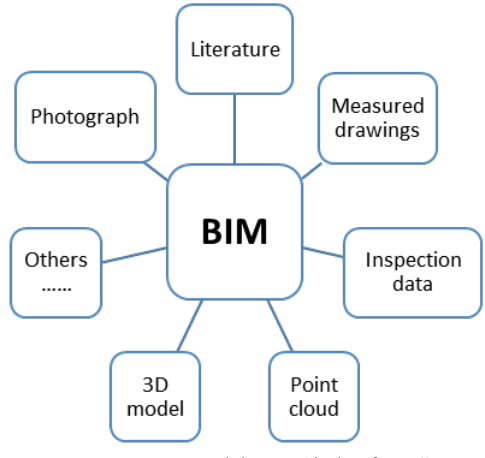
Figure 9. BIM model as an “index